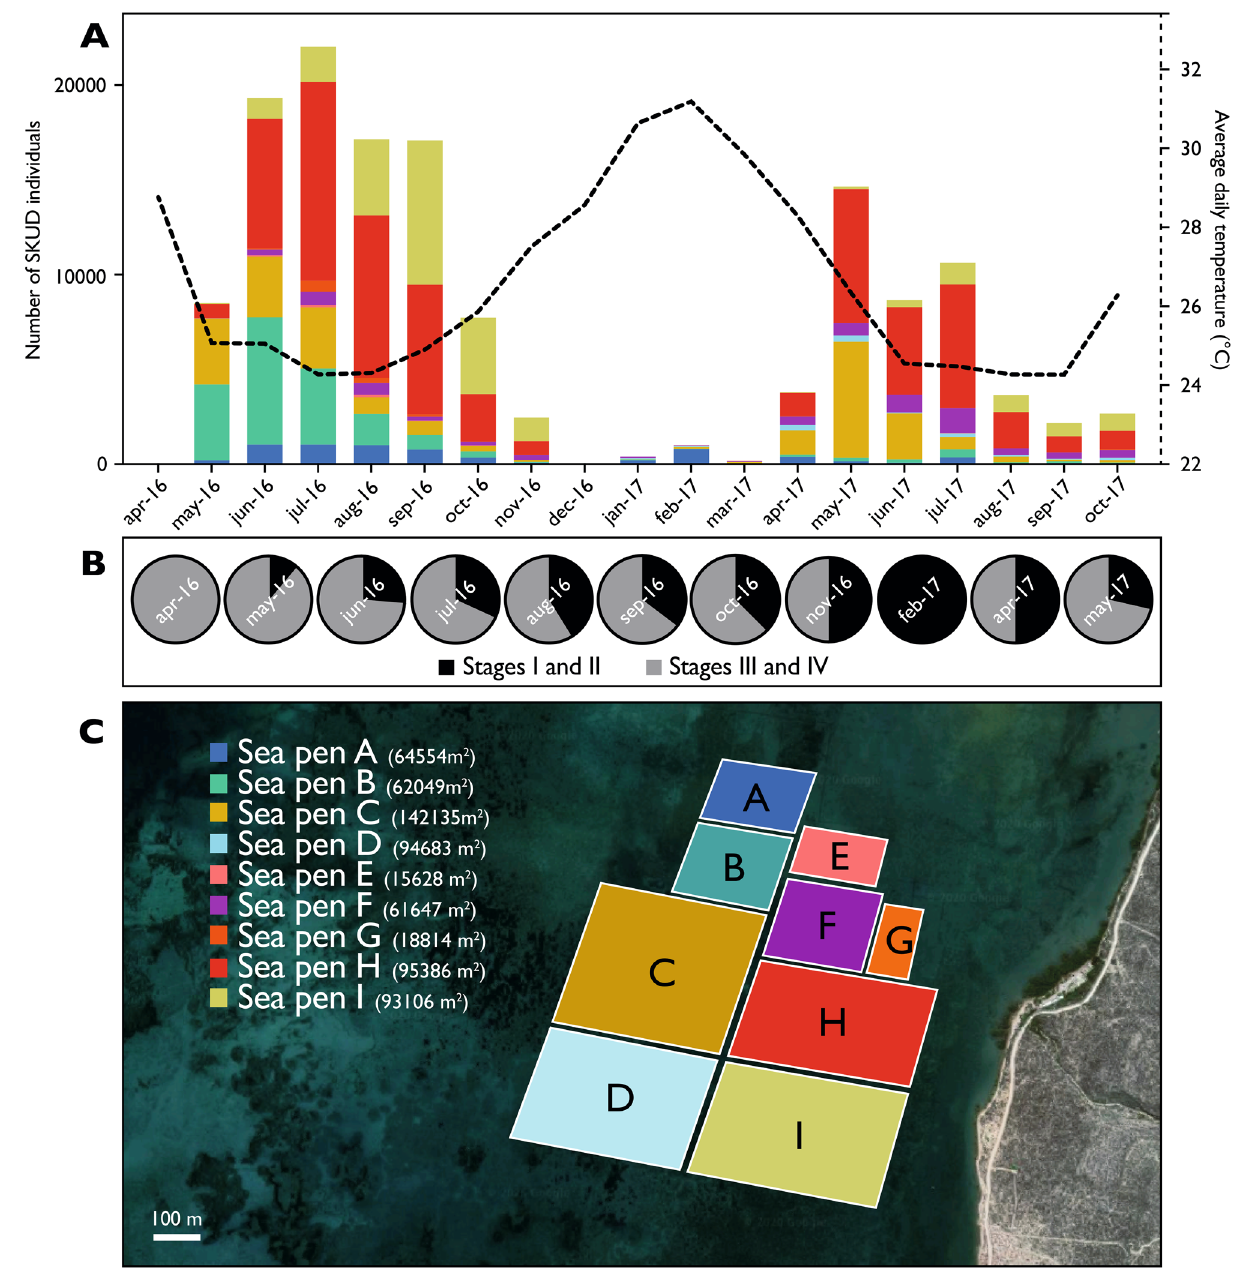
Figure 3. ( A ) Distribution of SKUD occurrence within IOT pens (Belaza, Toliara, Madagascar) between April 2016 and October 2017. The figure shows the monthly number of total sick Holothuria scabra individuals recorded in different IOT pens. The colour-code corresponds to the different pens that were investigated. The dotted line shows the evolution of average daytime temperatures measured in IOT pens (surface water). ( B ) Proportion of stages I/II and stages III/IV SKUD-affected Holothuria scabra sea cucumbers during selected months (see Fig. 2 for the description of the stages). ( C ) Organisation of IOT pens investigated in the present study. The map was obtained from Google map (https ://www.googl e.be/maps, accessed in May 2020, Images 2020 Maxar Technologies, Images 2020 the temperature varied between 23.34 and 25.88 °C. During the epidemic months in 2017 (May to July), the temperature varied between 23.25 and 26.87 °C. When the number of diseased individuals was close to zero, in December 2016, January 2017 and March 2017, the average daytime temperatures were 28.6, 30.6 and 29.8 °C, respectively (Fig. 3A). The occurrence of SKUD-affected sea cucumber was evaluated in nine sea pens (repre- sented in the Fig. 3C).